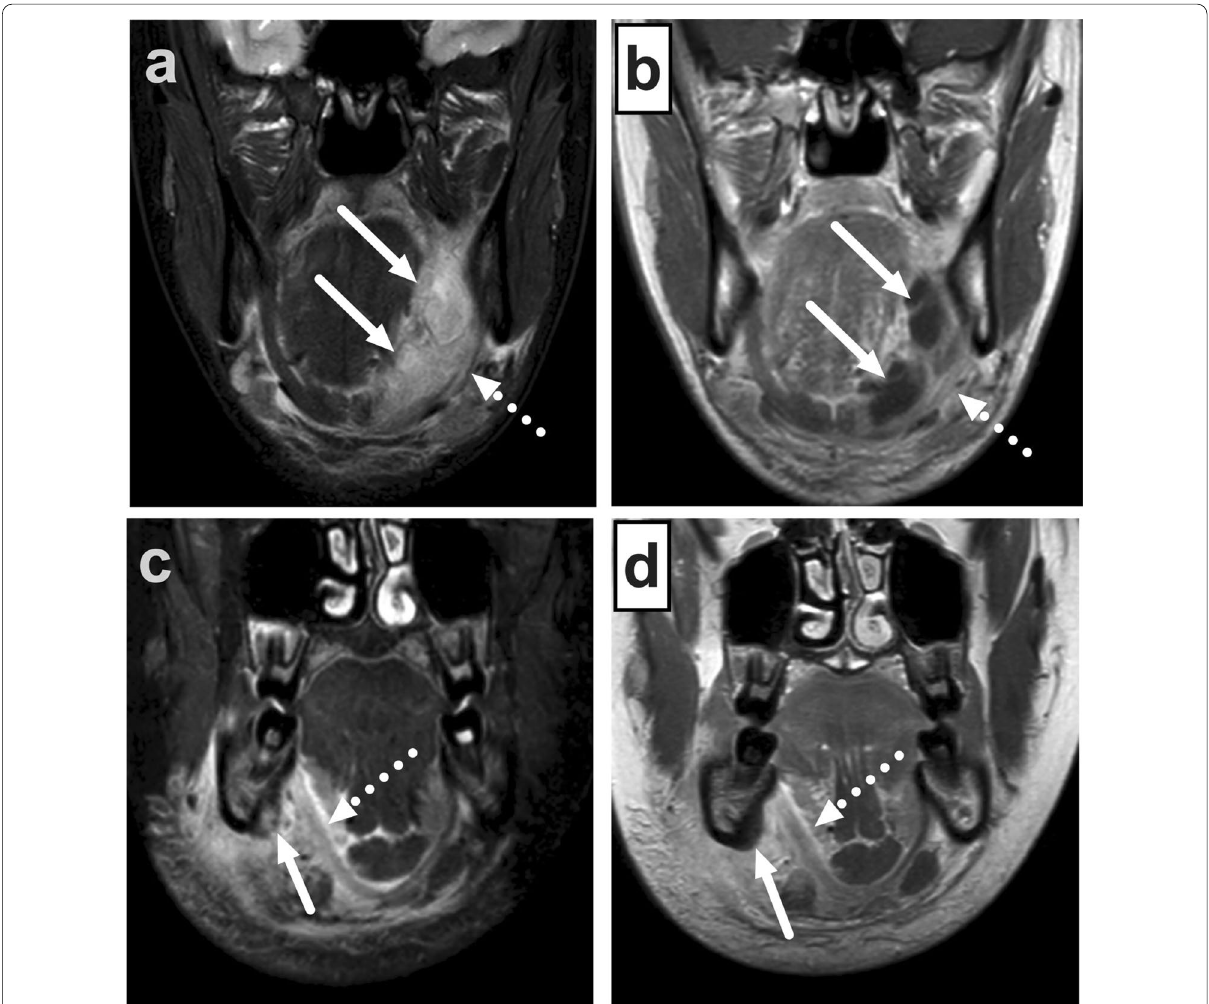
Fig. 17 Odontogenic maxillofacial infections in two patients ( a and b , c and d ). Coronal fat-suppressed T2-weighted ( a , c ) and post-contrast T1-weighted ( b , d ) images show sublingual abscesses (arrows in a and b ) above the mylohyoid muscle (dotted arrow), and a submandibular space subperiosteal abscess (arrow in c and d ) below the mylohyoid muscle (dotted arrow). Image modified from ref.